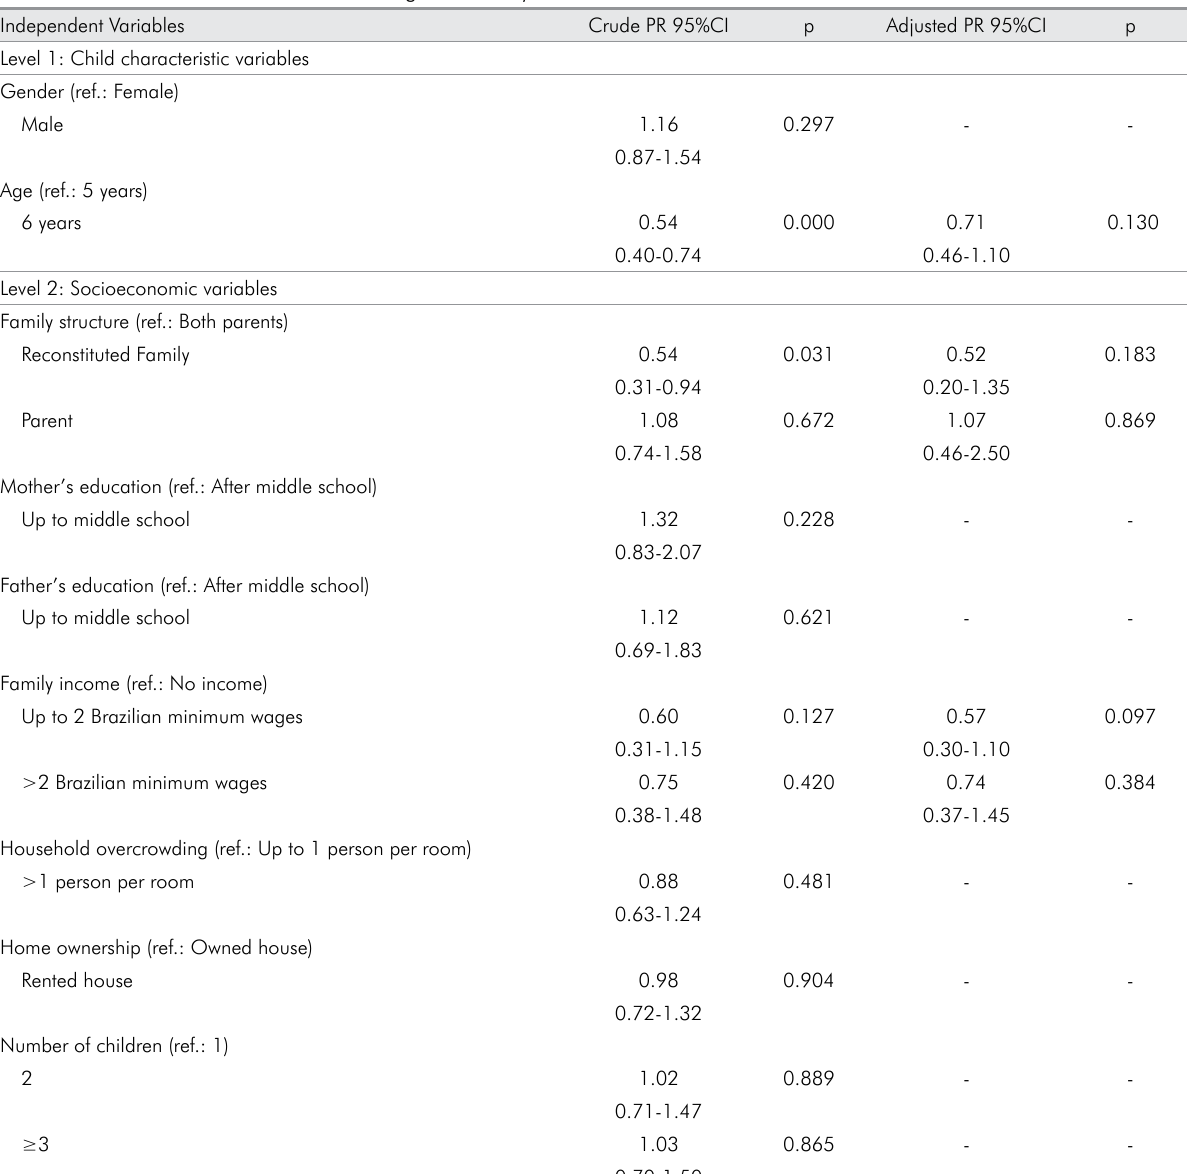
Table 2. Univariate and Multivariate Poisson Regression analysis of child-related and socioeconomic factors associated with dental trauma. Independent Variables Crude PR 95%CI p Adjusted PR 95%CI